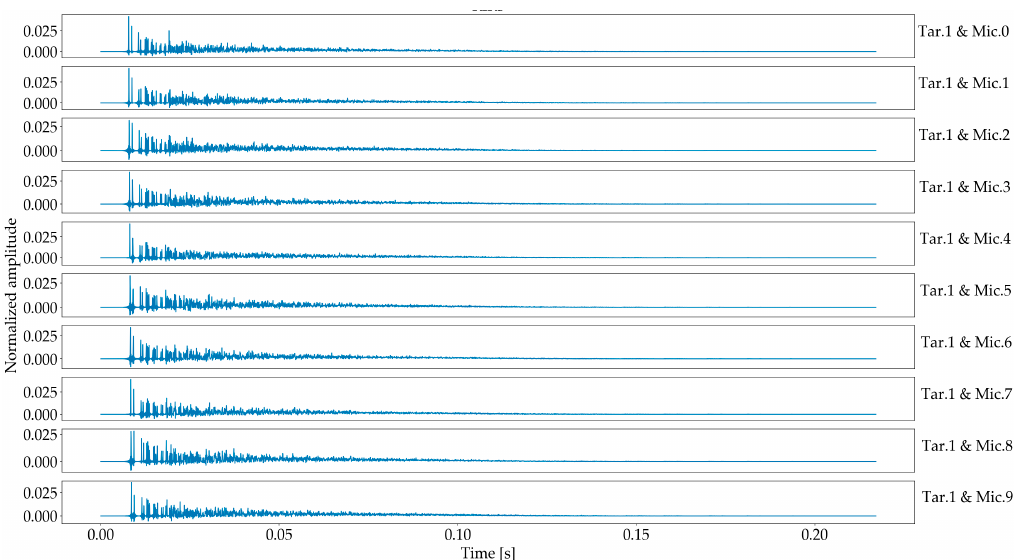
Figure 6. The RIRs between Target (Tar.) 1 and each microphone (Mic.) when the RT 60 is 500 ms.